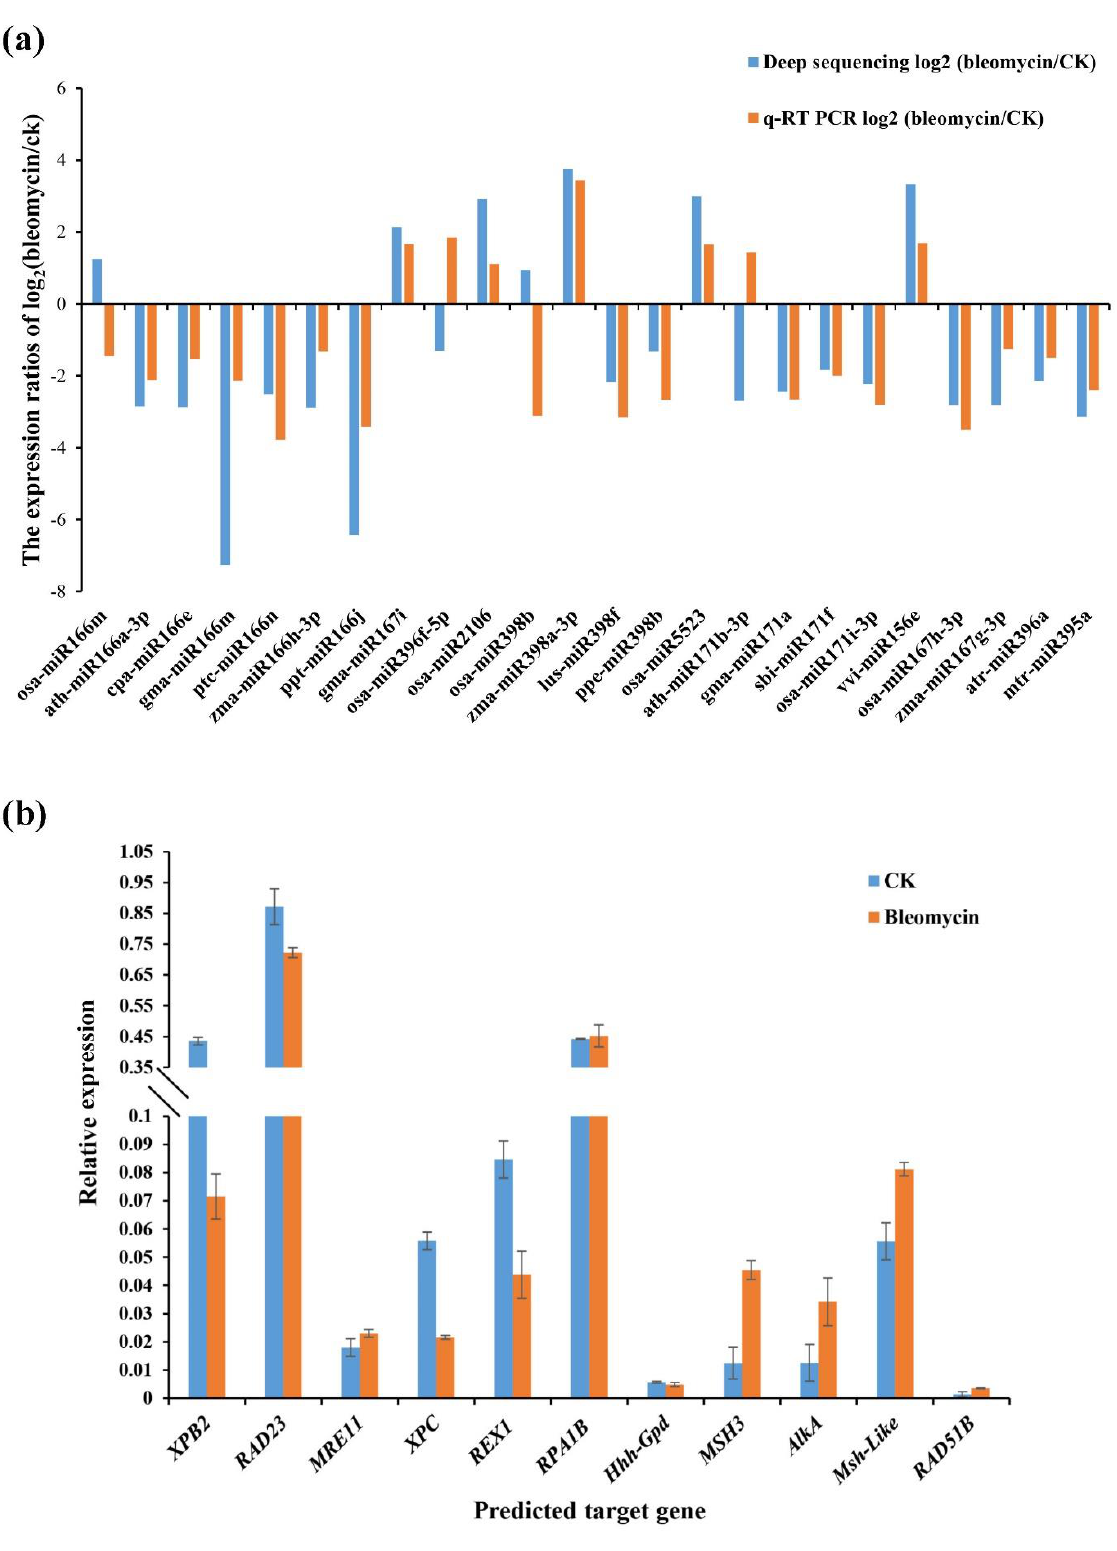
Figure 9. RT-qPCR validation of the expression levels of miRNAs and their gene targets. ( a ) The expression ratios [log2 (bleomycin/ck)] of the differentially expressed miRNAs along with target genes relating to DSB repair processes in rice were detected by RT-qPCR and deep sequencing; ( b ) Quantitative expression analyses of eleven target genes of selected miRNAs. The ubiquitin gene was used as the internal control for target gene expression. Each bar indicates the mean ± SE of triplicate assays.